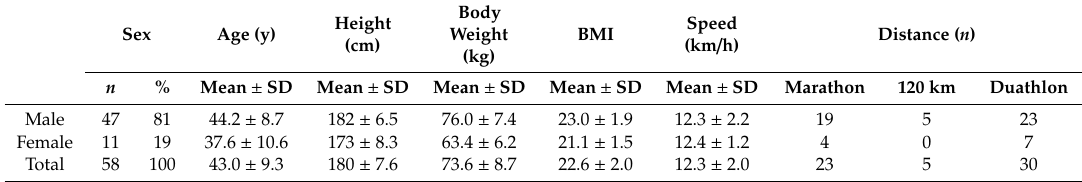
Table 2. Characteristics of the study